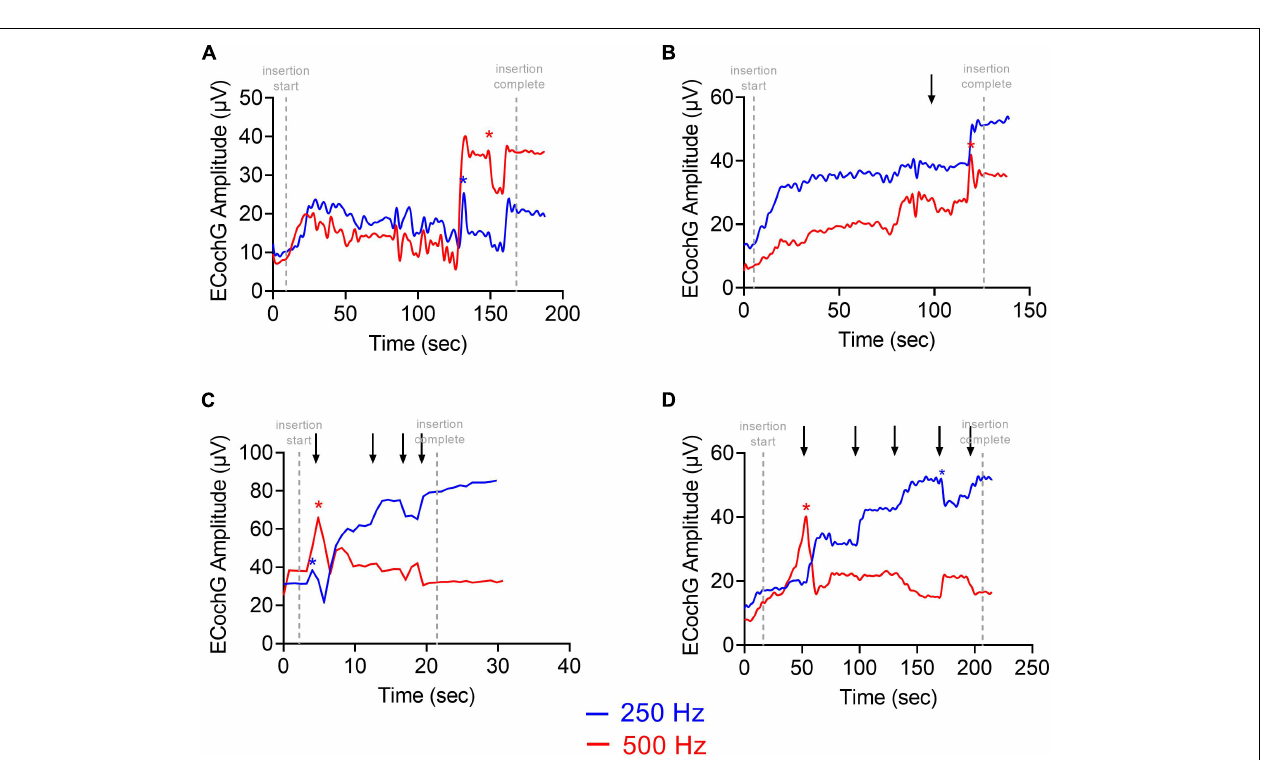
FIGURE 2 | Individual low-frequency hearing preservation results as related to audiogram thresholds shifts for 1-month post-activation are shown here for all subjects.